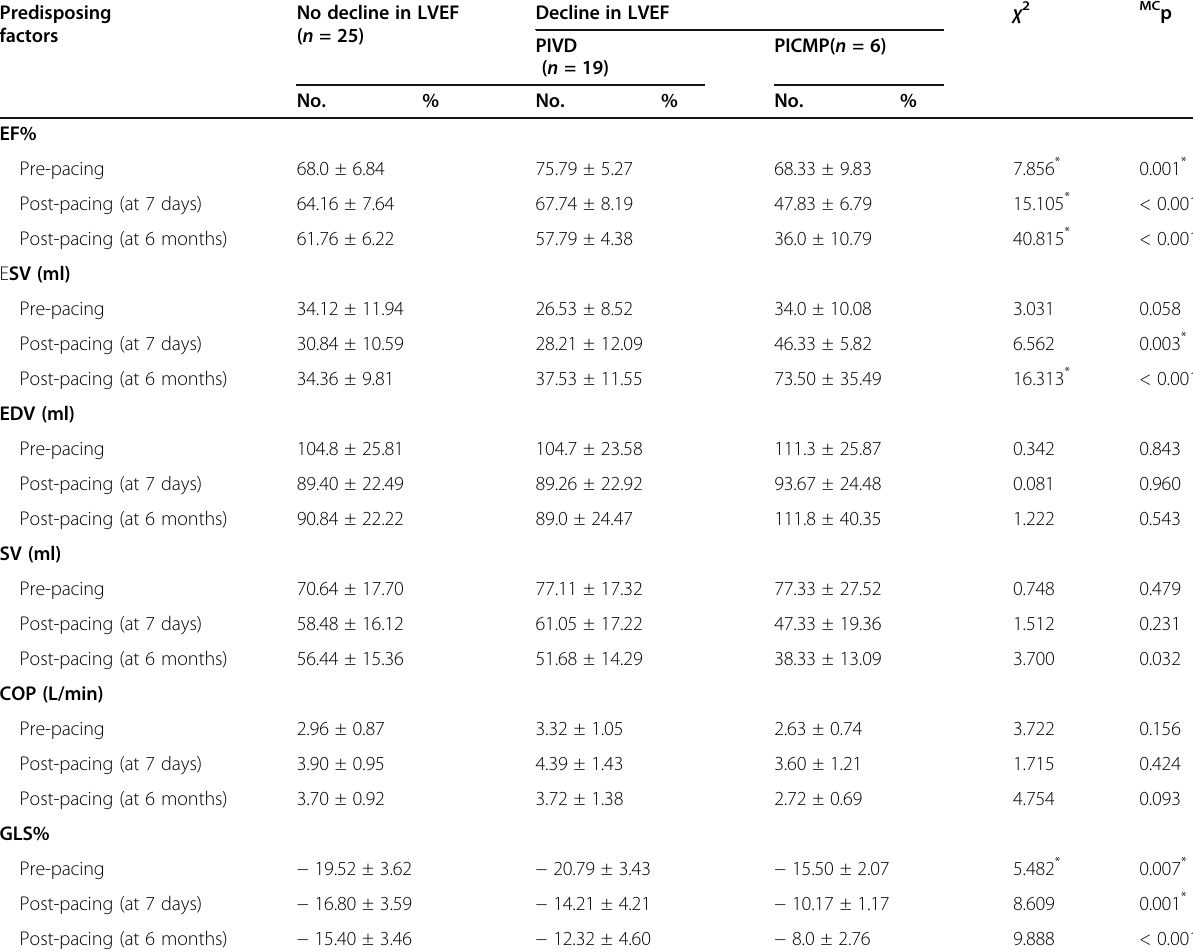
Table 1 Comparison between the three studied groups according to echo parameters and GLS Predisposing